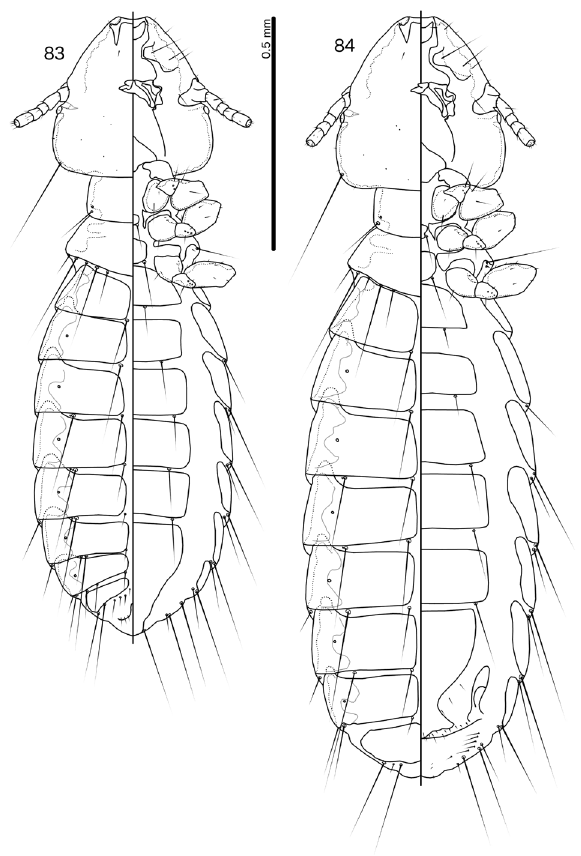
content, and illustrated approximately; seemingly nar- rowly rectangular. Mesosomal lobes slender, converging in distal end, fused distally. Mesosomal chaetotaxy as in Figure. 87. Rugose area absent. Gonopore almost termi- nal, semi-oval. Parameral heads large (Fig. 88), param- eral blades of approximately uniform width in proximal half, tapering in distal half, with pst1–2 as in Figure 81. Measurements ( n = 1): TL = 1.32; HL = 0.34; HW = 0.33; Female. Thoracic and abdominal chaetotaxy as in Fig-